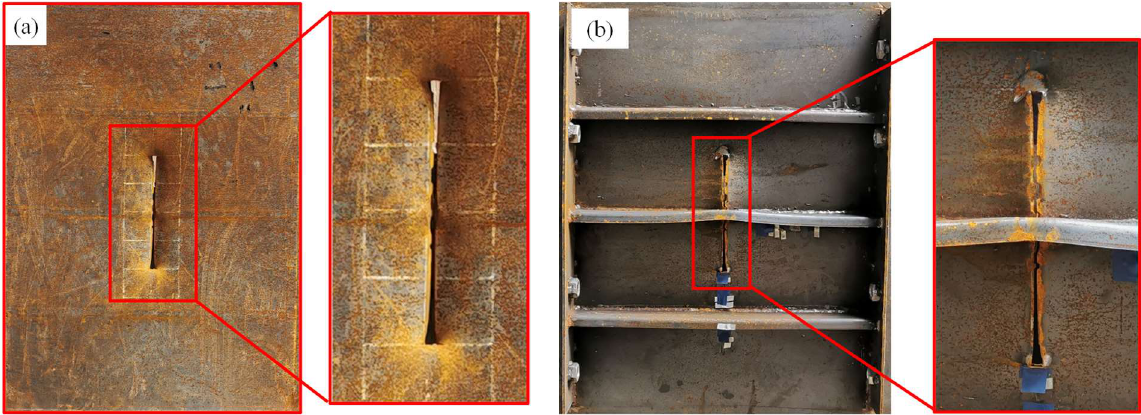
Figure 10. Deformation of the conventional stiffened plate under centric impact: ( a ) front side; ( b ) back side.